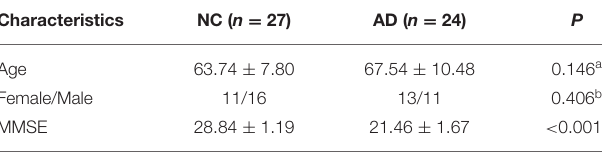
TABLE 1 | Demographics and clinical information.